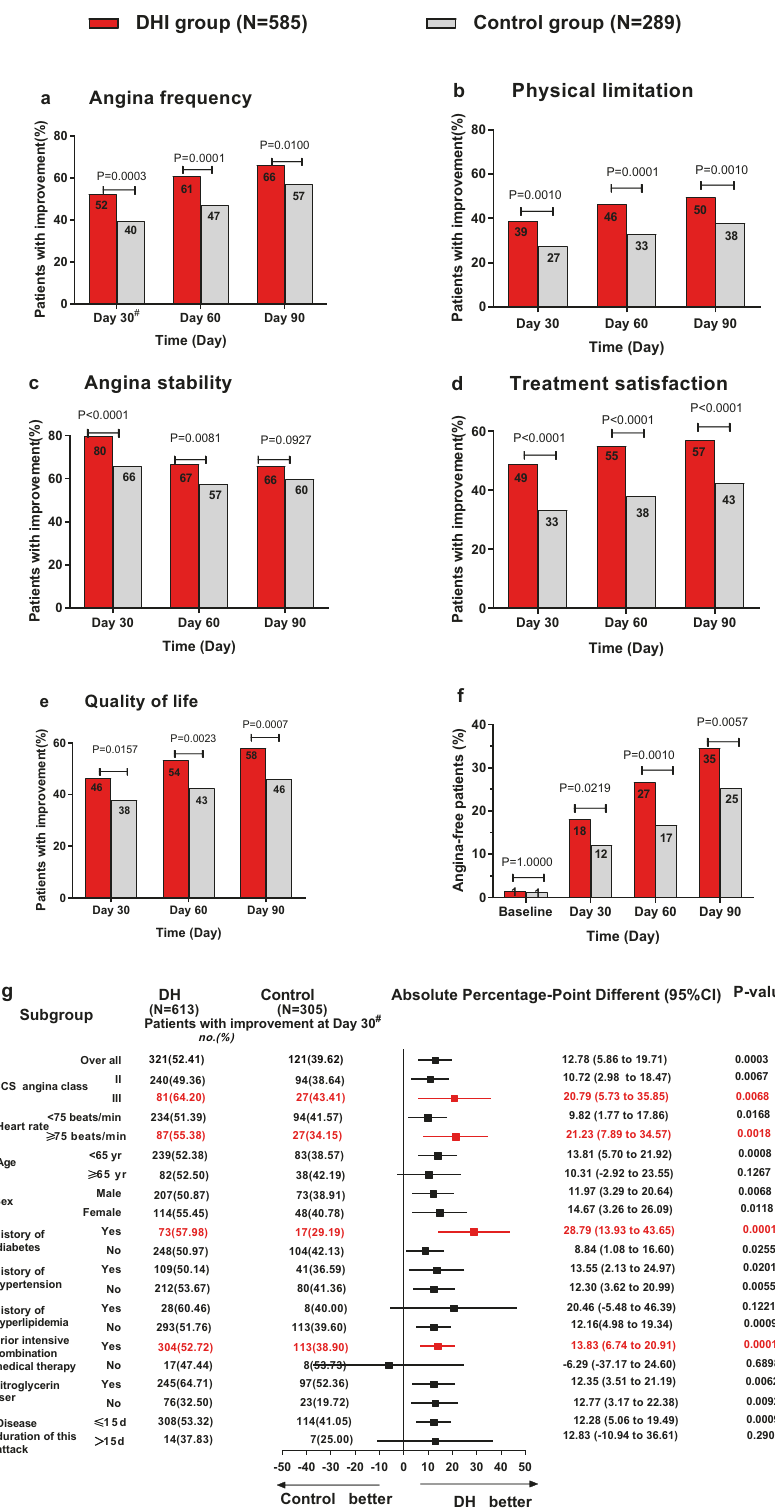
Fig. 2 Changes in Seattle Angina Questionnaire scores. a – e Patients with clinically signi fi cant improvements from baseline in their Seattle Angina Questionnaire scores; f Freedom from angina over time as assessed by the angina frequency scale of the Seattle Angina Questionnaire (scored out of 100); g Forest plot of the primary outcome in prespeci fi ed subgroups (at Day 30). “ # ” in Figs. 1a and 1g indicates that the primary outcome was calculated from the imputed data, with n = 613 in the DHI group and n = 305 in the control group